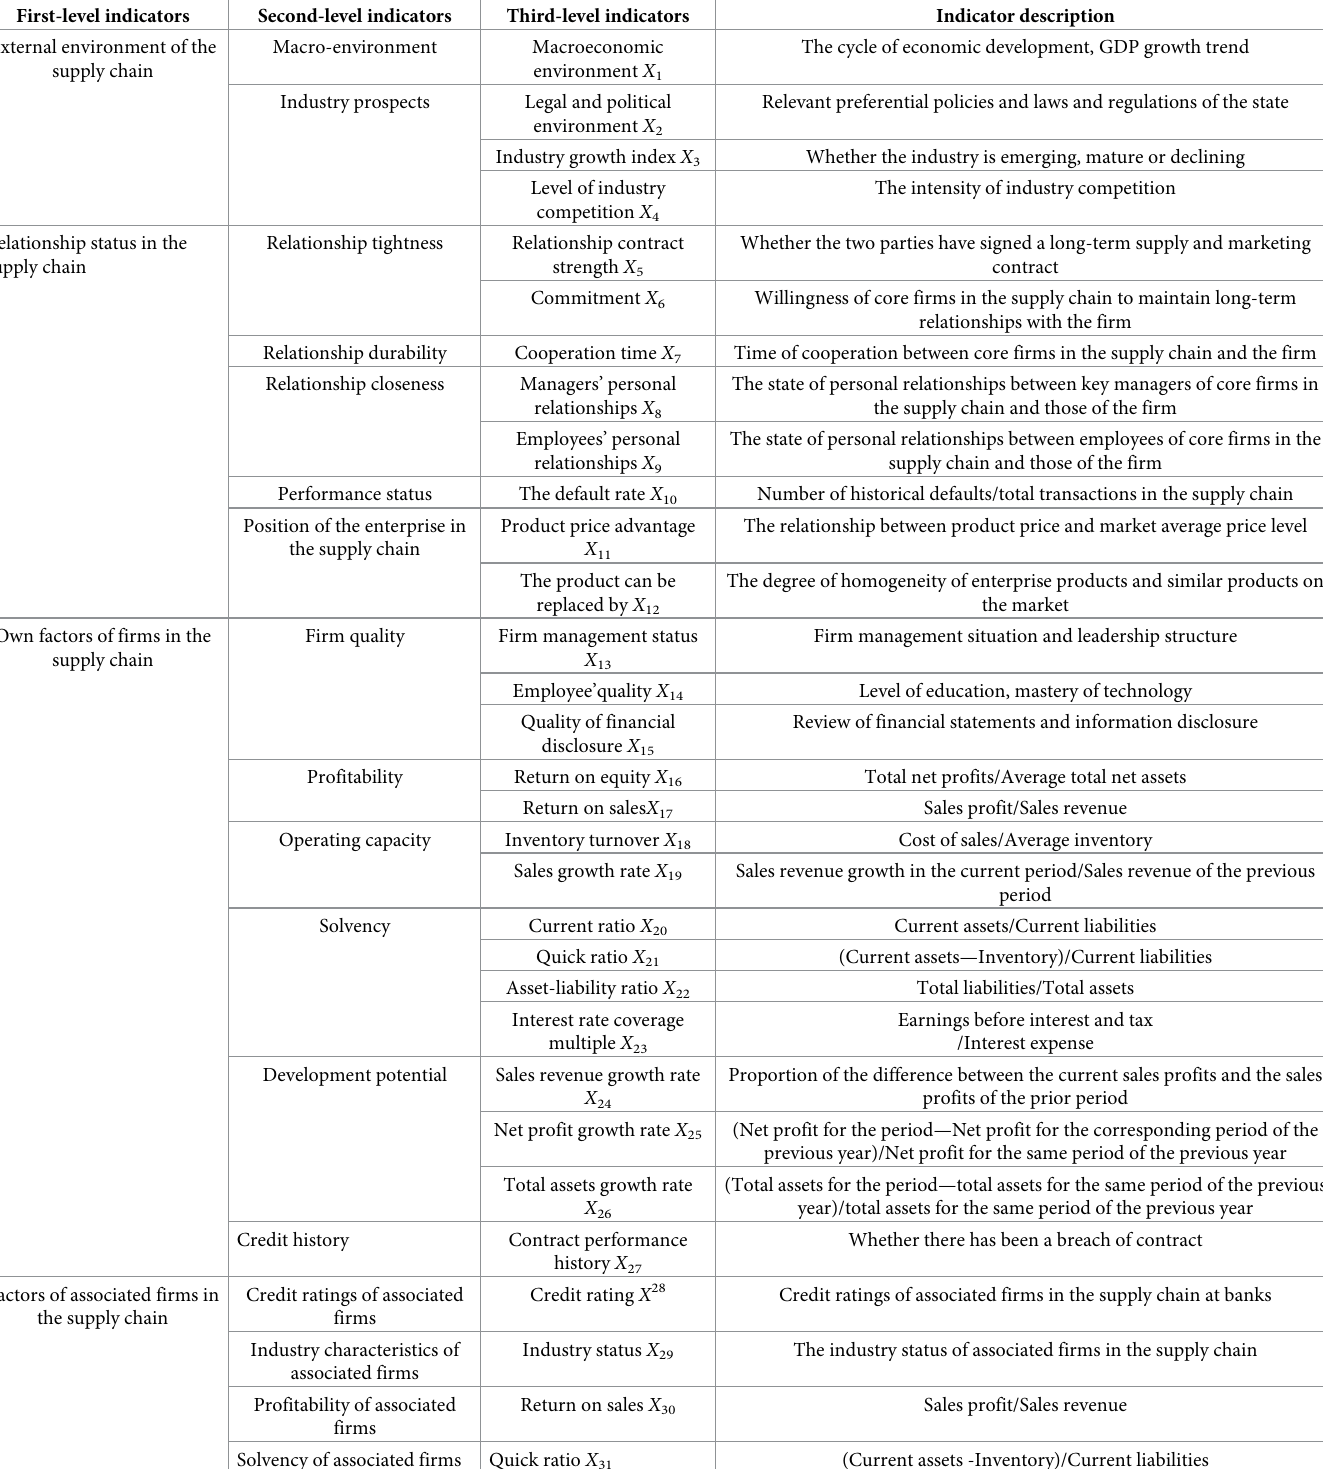
Table 1. The system of indicators for assessing the own credit risk of firms in the supply